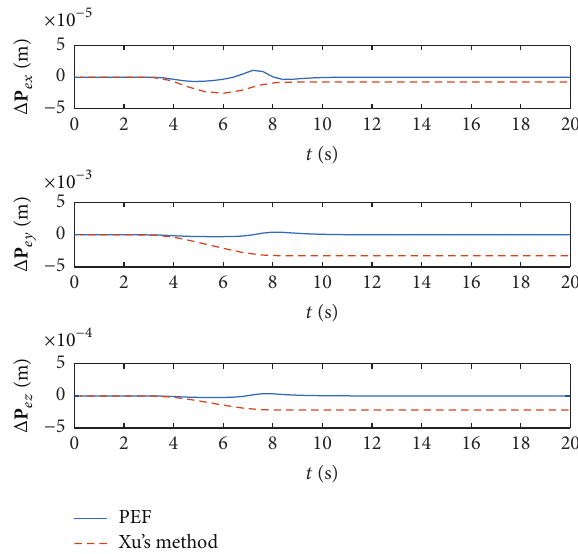
Figure 3: The variation of the end-effector’s positon